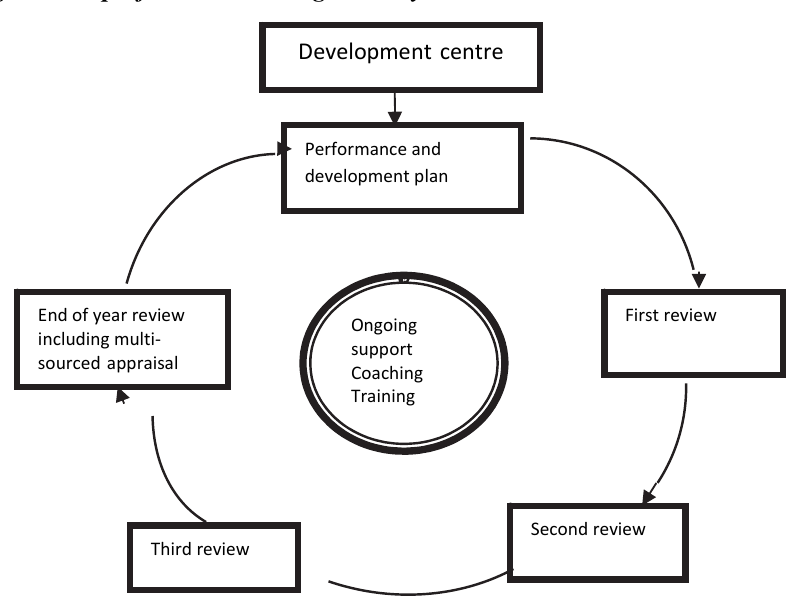
Figure 6: A performance management cycle